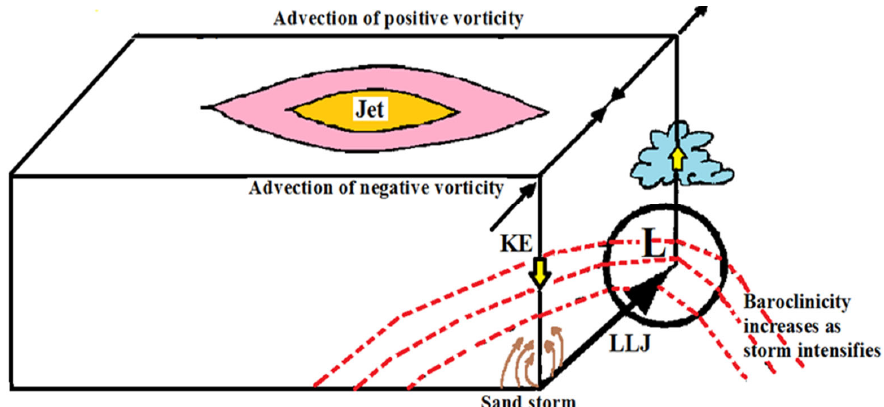
Figure 15. Schematic diagram for dust storm associated with desert